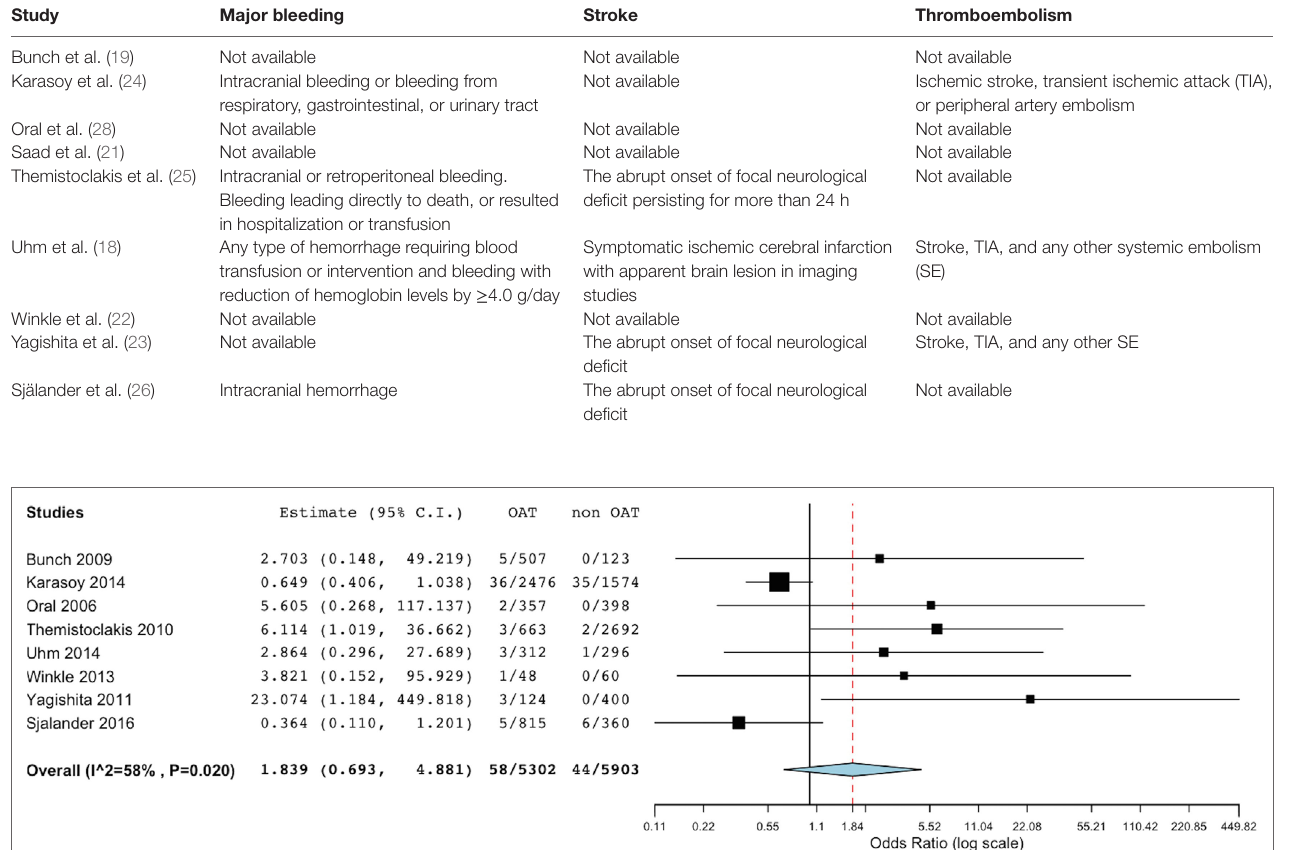
taBLe 3 | Endpoints’ definition for any study included in the meta-analysis.